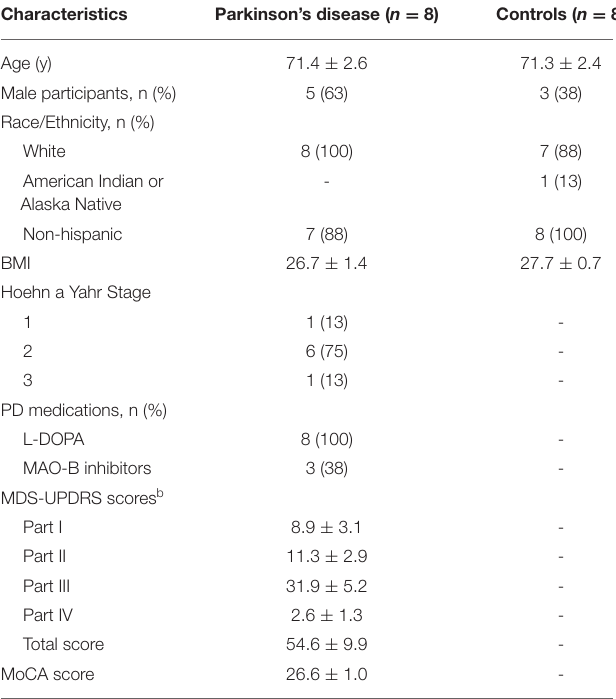
TABLE 1 | Baseline characteristics of participants in the Parkinson’s disease and control groups a . Characteristics